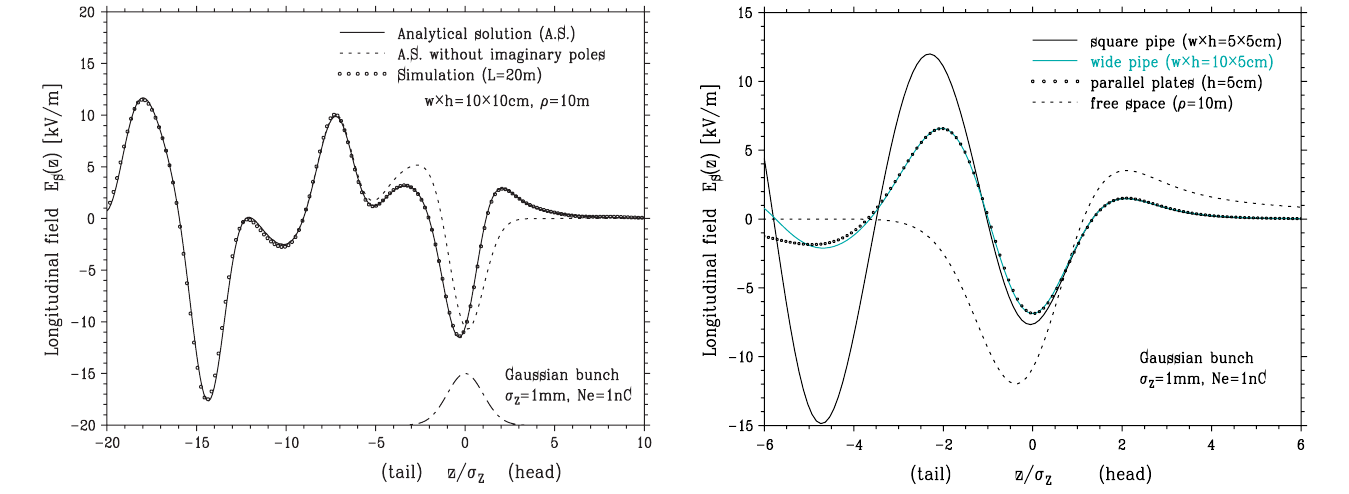
11. The longitudinal field of CSR in a square pipe. The FIG. 12. (Color) Comparison of rectangular pipe with parallel horizontal axis is the longitudinal position in the Gaussian bunch plates. The black solid line represents the field in a rectangular ¼ 1 mm . The dot-dashed in units of the rms bunch length (cid:1) pipe of w (cid:11) h ¼ 5 cm (cid:11) 5 cm ; the cyan solid line is for a wide z ¼ þ 1 nC line is the Gaussian bunch. The bunch charge is q pipe of w (cid:11) h ¼ 10 cm (cid:11) 5 cm . They are obtained from e (positron), the Lorentz factor is (cid:5) ¼ 1 . The solid line represents Eq. (152). The small circles show the field between parallel the analytical solution of Eq. (152), the small circles indicate the plates with a spacing h ¼ 5 cm , which is computed by a nu- simulation result in which we set the magnet length to 20 m so merical Fourier transform for Eq. (76). The dashed line is the . that the field becomes nearly stationary in a range of j z j < 20 (cid:1) longitudinal field in free space, given by Eq. (83). The bunch is z The dashed line is the analytical solution of Eq. (152) without K ¼ 1 mm , and the charge is q ¼ Gaussian with a length (cid:1) p z e ¼ (cid:2) x ¼ 5 cm þ 1 nC . The bending radius is (cid:3) ¼ 10 m , and the Lorentz factor of Eq. (155). The chamber cross section is x b a and h ¼ 10 cm , and the bending radius is (cid:3) ¼ 10 m is (cid:5) ¼ 1